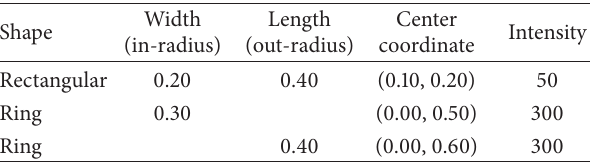
Table 2: Geometric parameters of the initial distribution. Shape